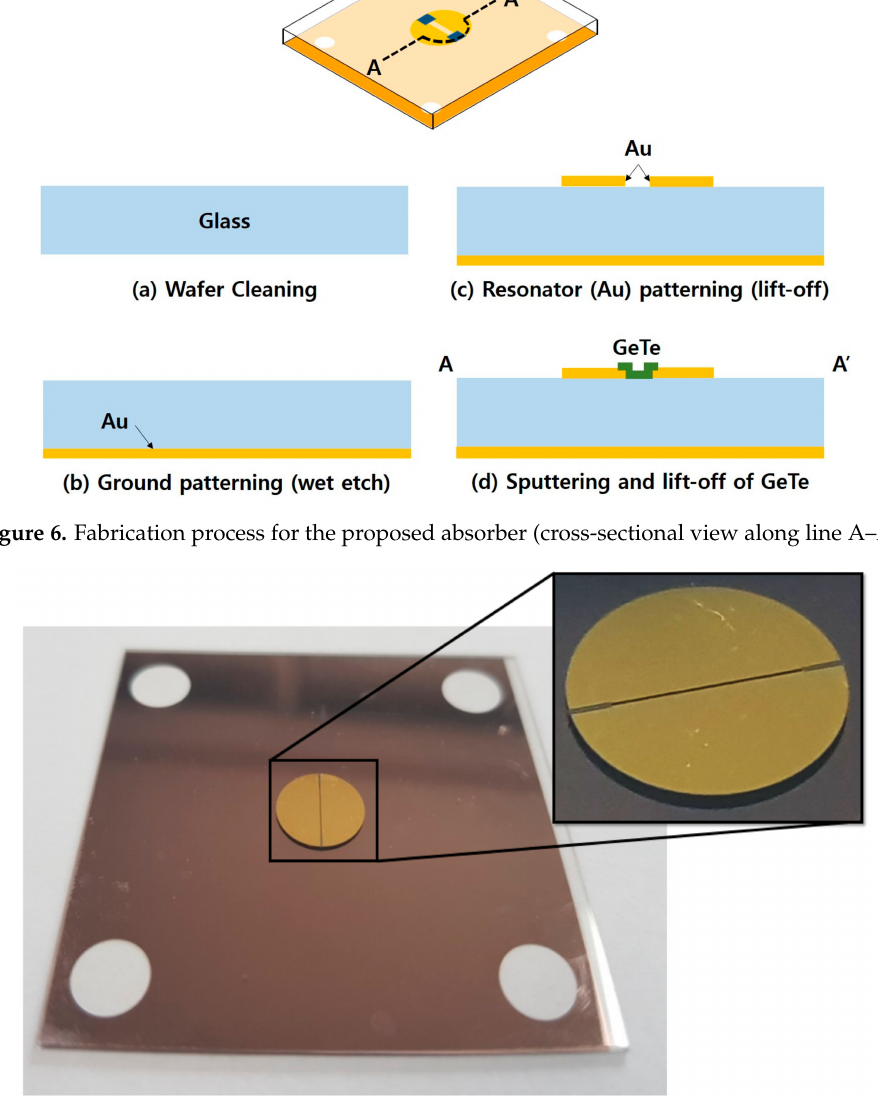
Figure 7. Photograph of fabricated absorber